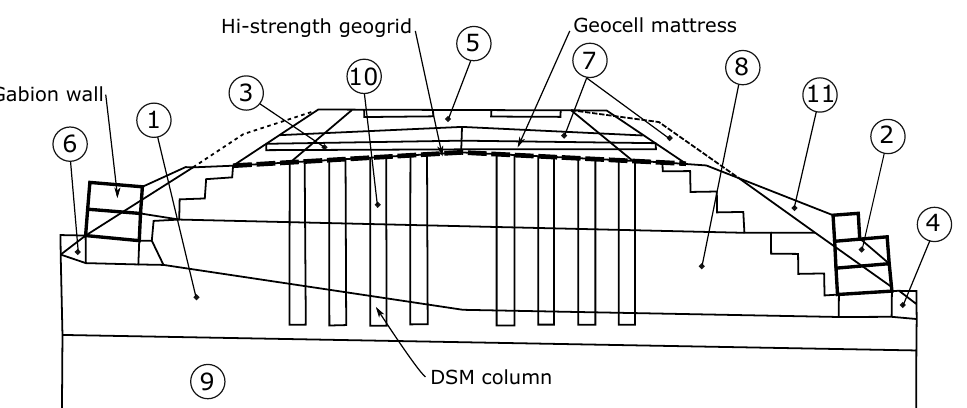
Figure 4. Cutout of the FEM model - detail of the embankment. (The numbers in circles refer to the material characteristics summarised in Table (1)).